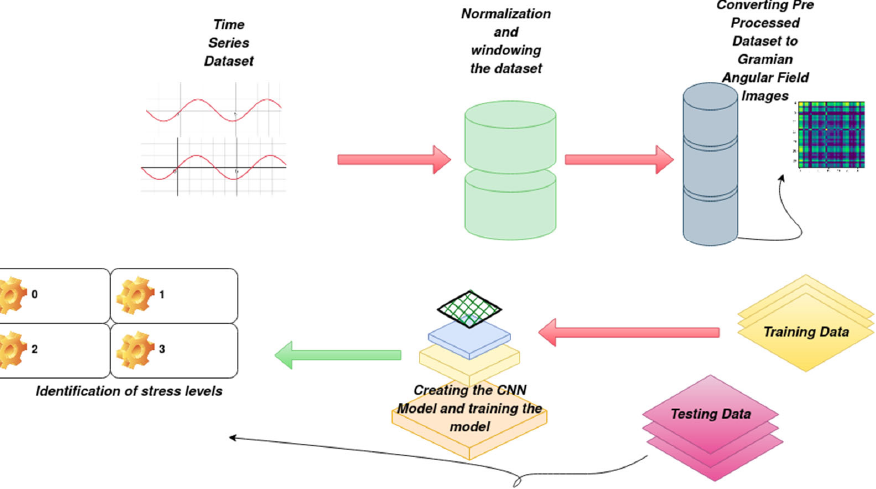
Figure 1. Illustration of the whole pipeline of our proposed image ‐ encoding ‐ based deep neural network for mental stress detection from wearable physiological sensors.